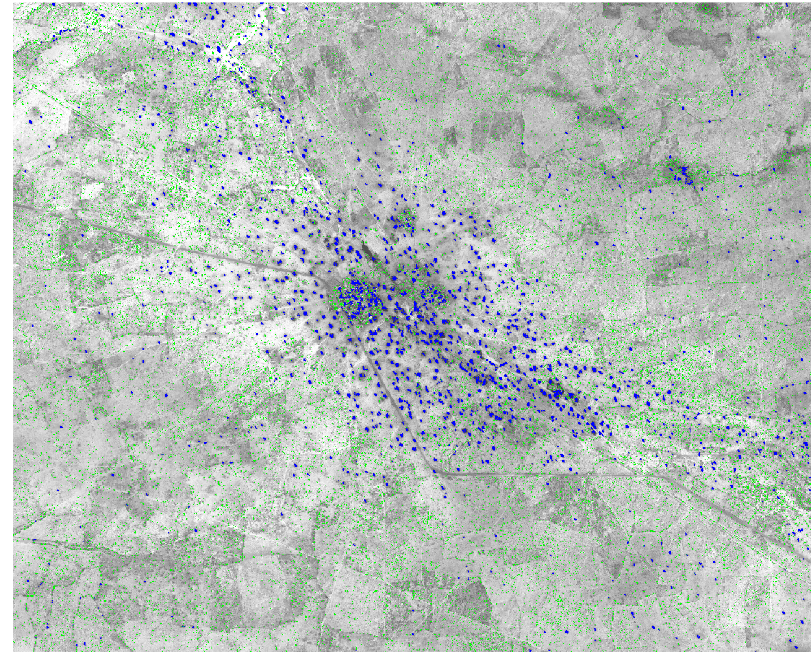
Figure 4. Classification in 3 classes from 12 granulometric levels. Here, 82,258 small spots (green class) and 1737 large spots (blue class) were identified (for counting and to avoid confusion between classes pixels adjoins to a class of higher size were coded as the higher class). Guileyni, 2011.